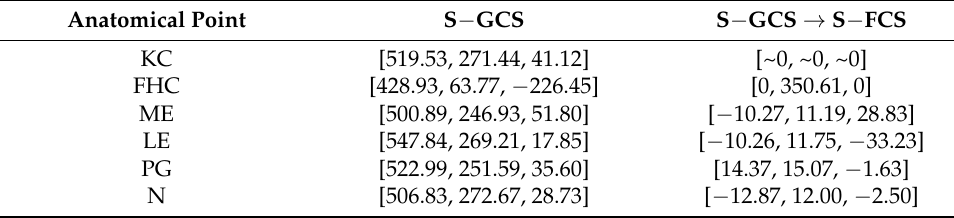
Table 2. Anatomical points marked on the printed bone model with probe sensor.